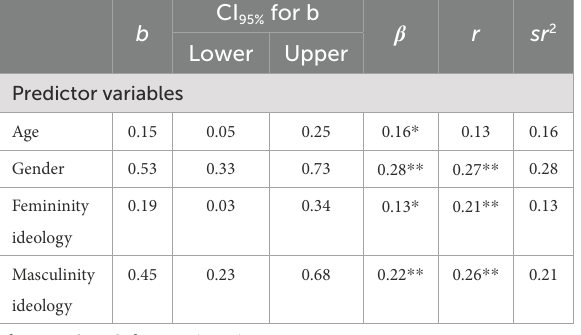
TABLE 4 Linear multiple regression predicting social media for competitive activity